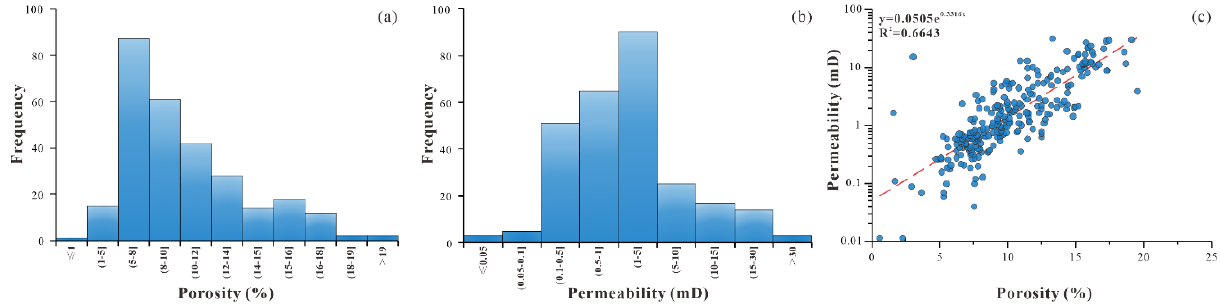
Figure 5. Physical properties of sandstone reservoirs in the Lower Jurassic in the Niudong area, northern margin of Qaidam Basin: ( a ) distribution of porosity; ( b ) distribution of permeability; ( c ) relationship between porosity and permeability.